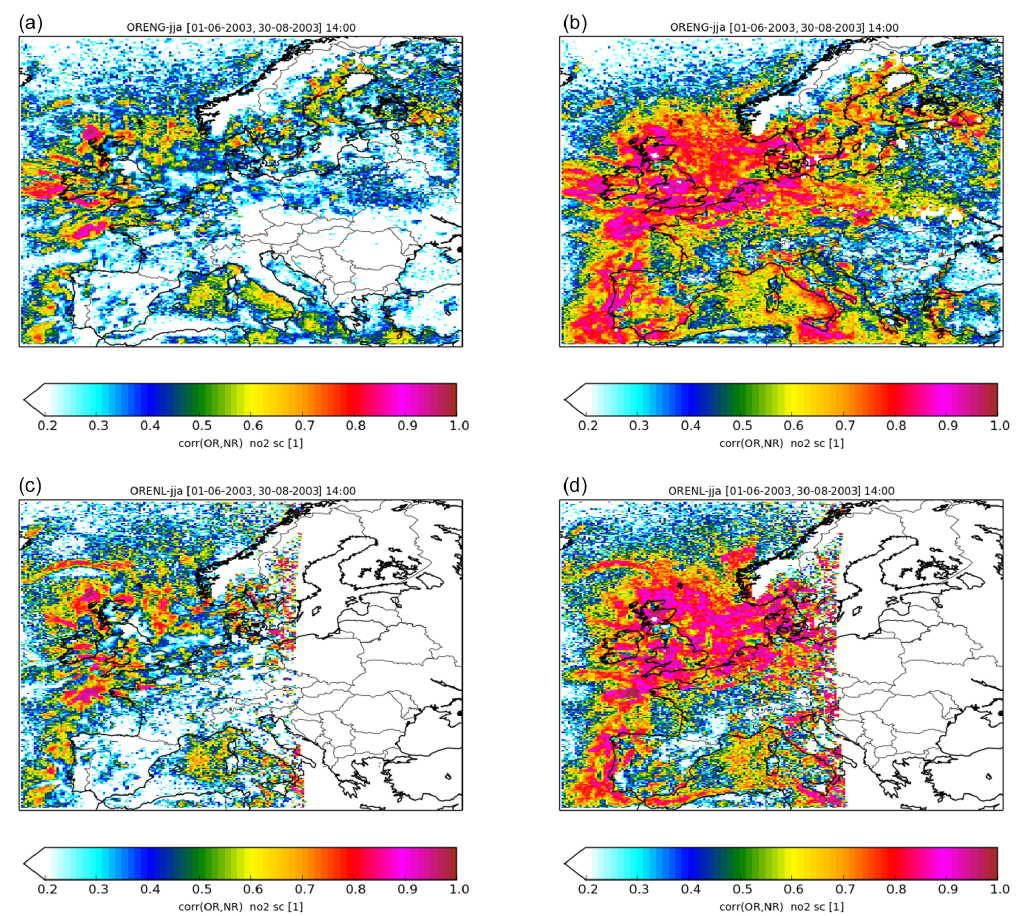
Figure 11. Summer period (JJA 2003) temporal correlation of modelled NO 2 columns at 14:00UTC with synthetic observations for the control run without assimilation (a, c) and with assimilation (b, d) of ground-based O 3 + S4 NO 2 (b) and ground-based O 3 + S5P NO 2 (d)